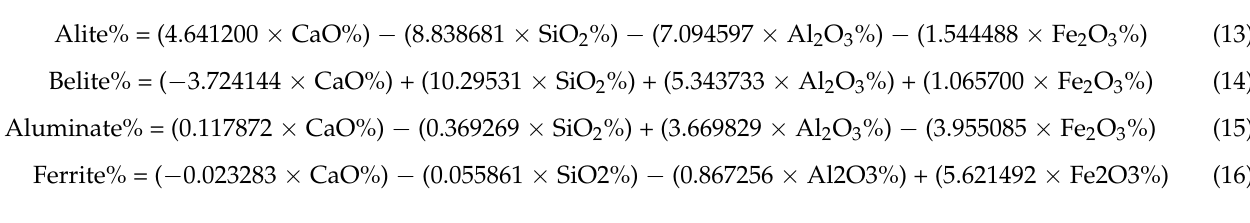
Table 5. Chemical compositions of the cement compounds used in the Taylor models [19]. Weight Ratio